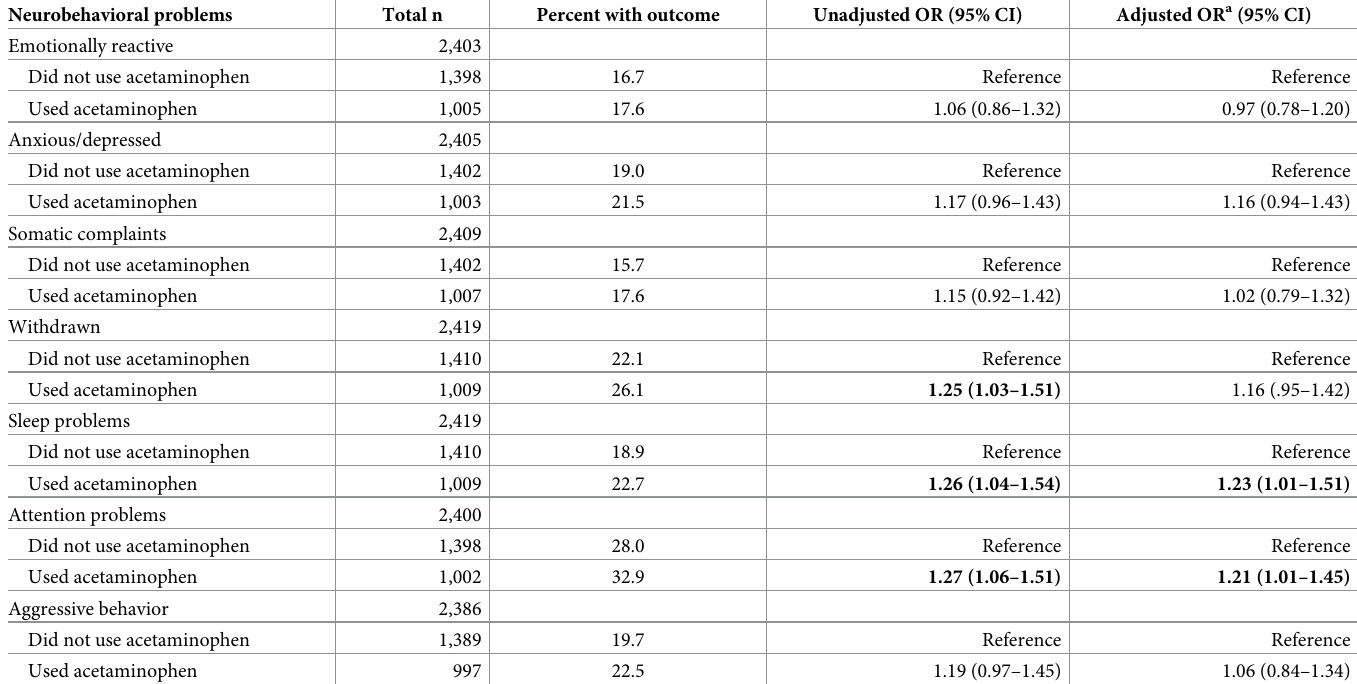
Table 3. Association between acetaminophen exposure during pregnancy and neurobehavioral problems in 3-year-old children. Neurobehavioral